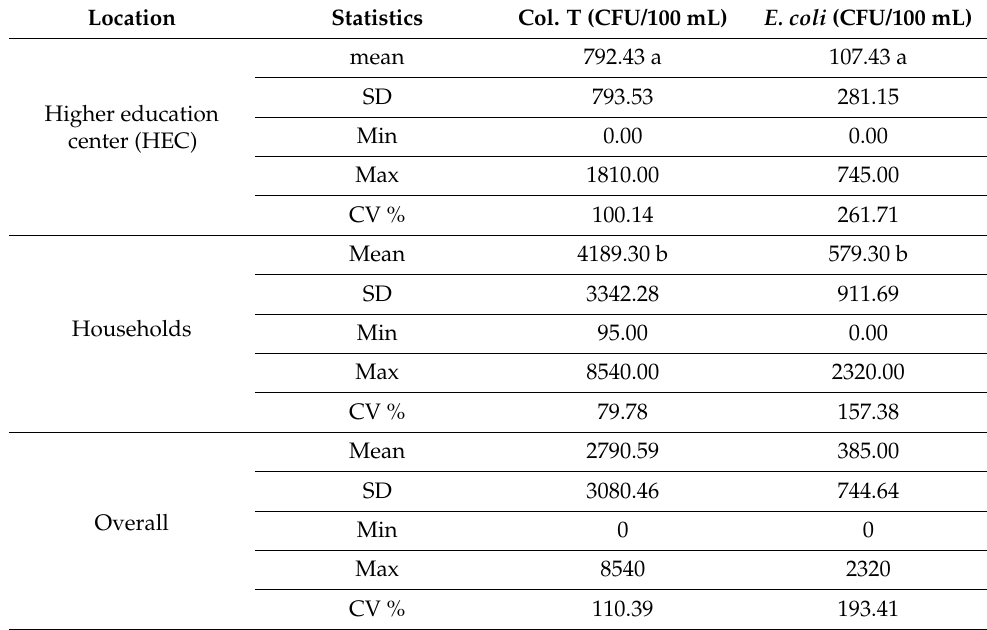
Table 3. Results of the descriptive statistics of the microbiological